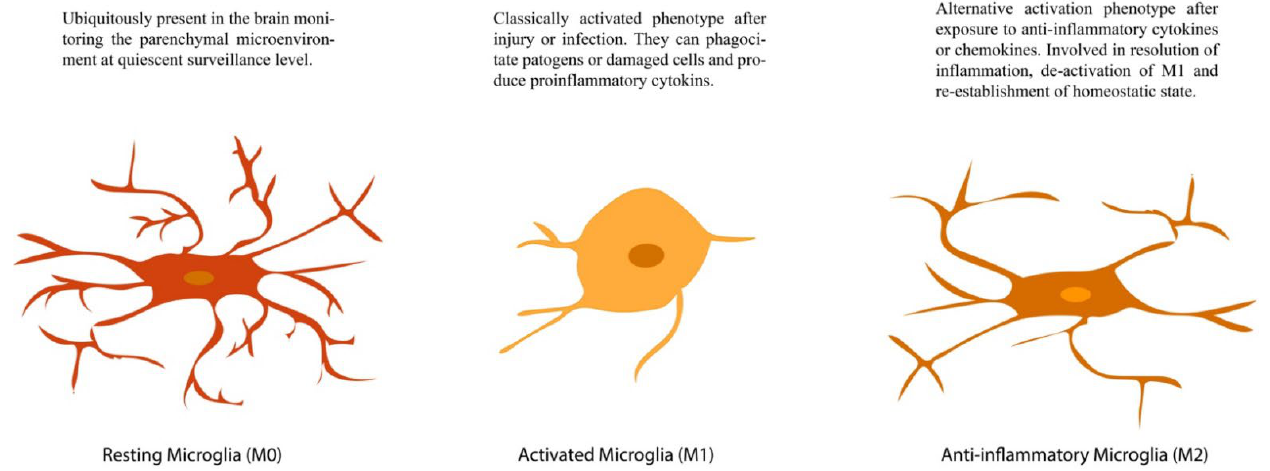
Figure 4. Activation states in microglial cells. Schematic representation of an M0 ( left ), M1 ( center ), and M2 ( right ) microglia.